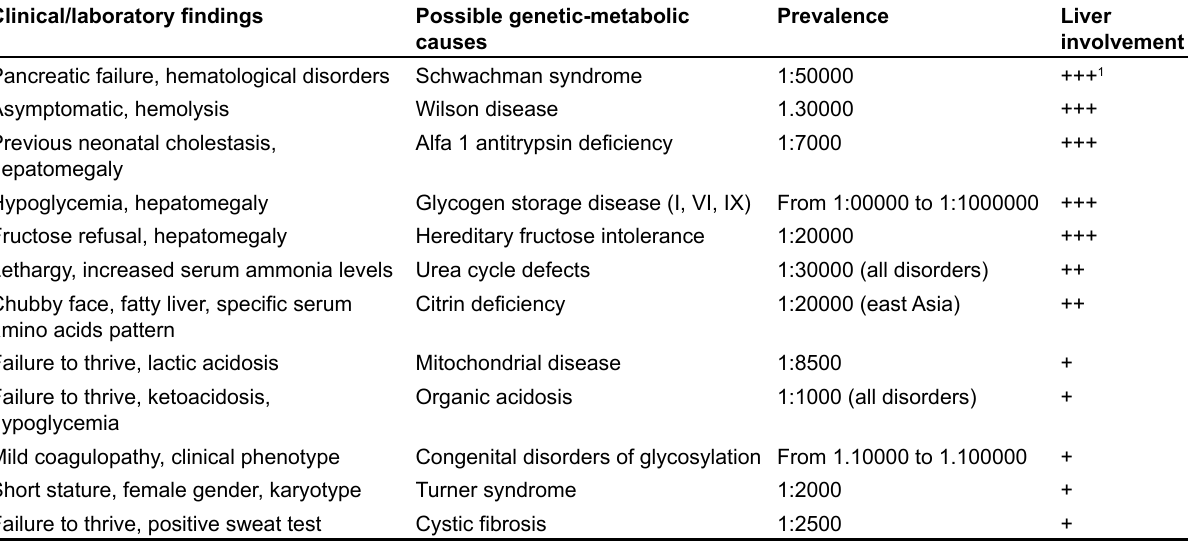
Table 2. Clinical and laboratory findings useful for orienting diagnosis of some genetic metabolic liver diseases with hepatic steatosis [19]